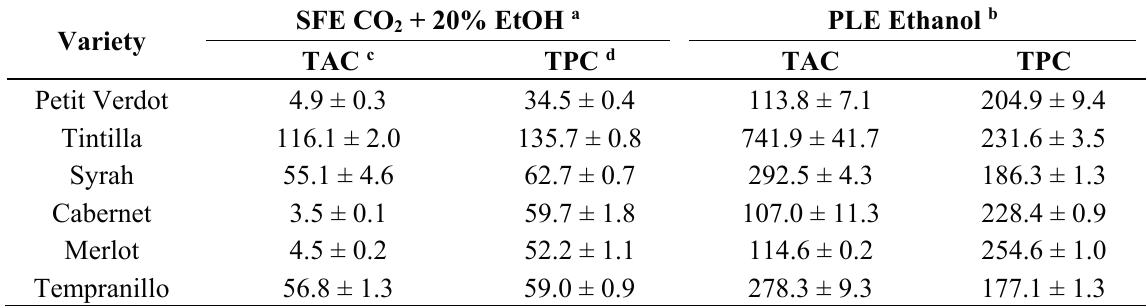
Table 2. Concentration of anthocyanins and phenolics in extracts obtained by SFE and PLE from different varieties of red grape